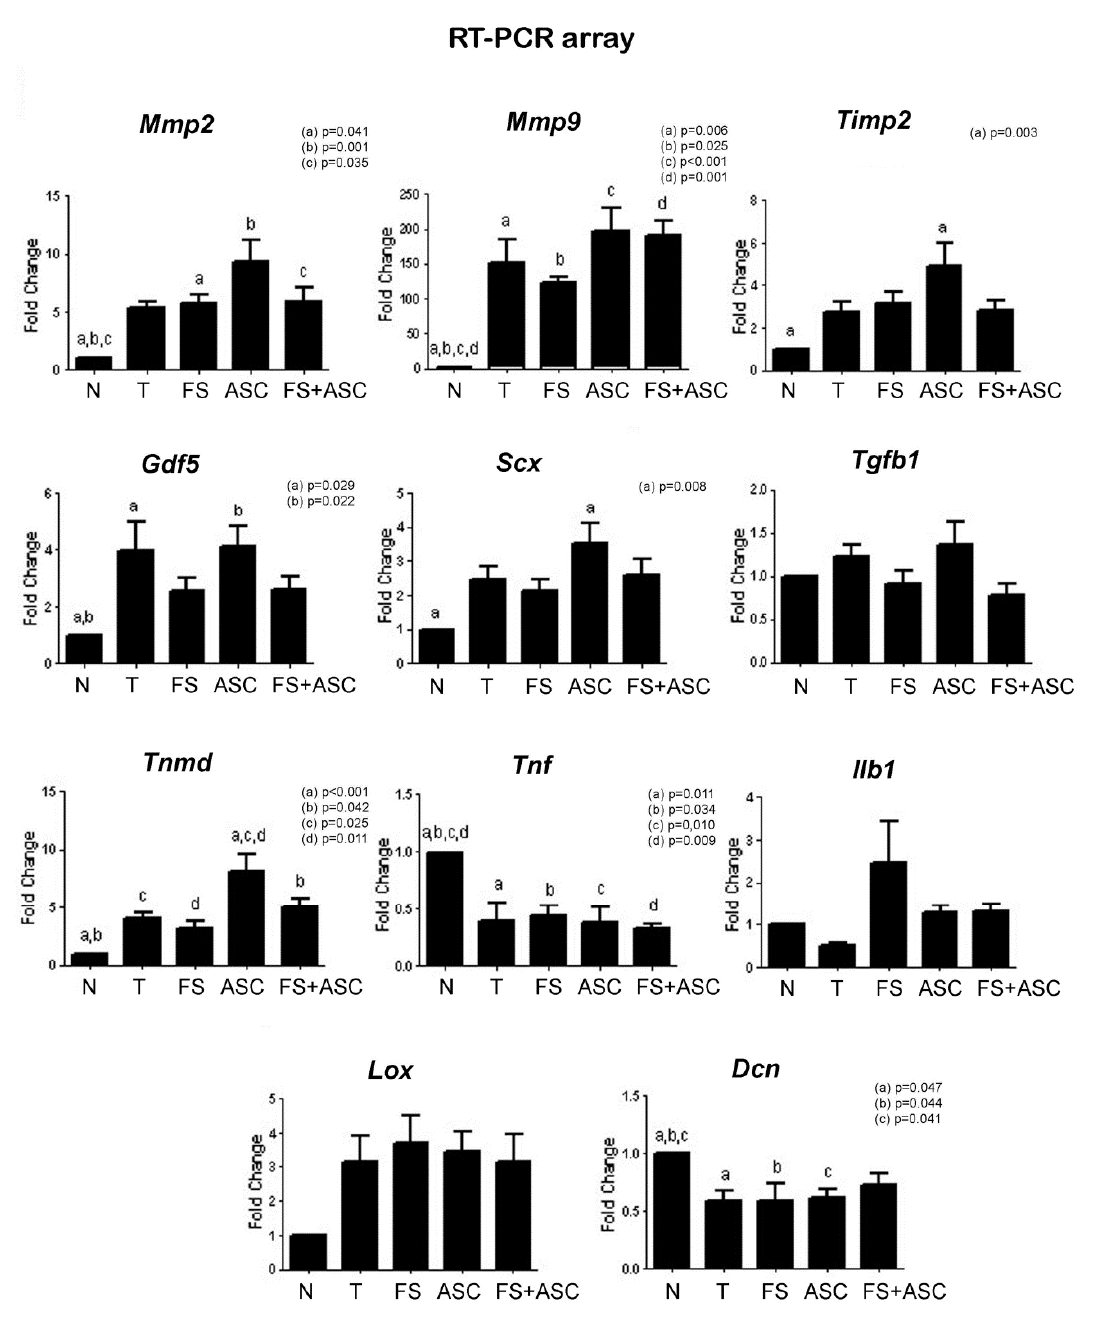
Figure 6. Real-time PCR array data of genes on the 21st day after the tendon transection ( n = 4). Note the higher Tnmd expression in the ASC group in relation to the T and FS. Difference between N group and T, FS, ASC and FS + ASC groups can be observed for genes expression of Mmp2 , Mmp9 , Timp2 , Gdf5 , Scx , Tnmd , Tnf and Dcn . Same letters (a, b, c, d) = significant difference between the groups.